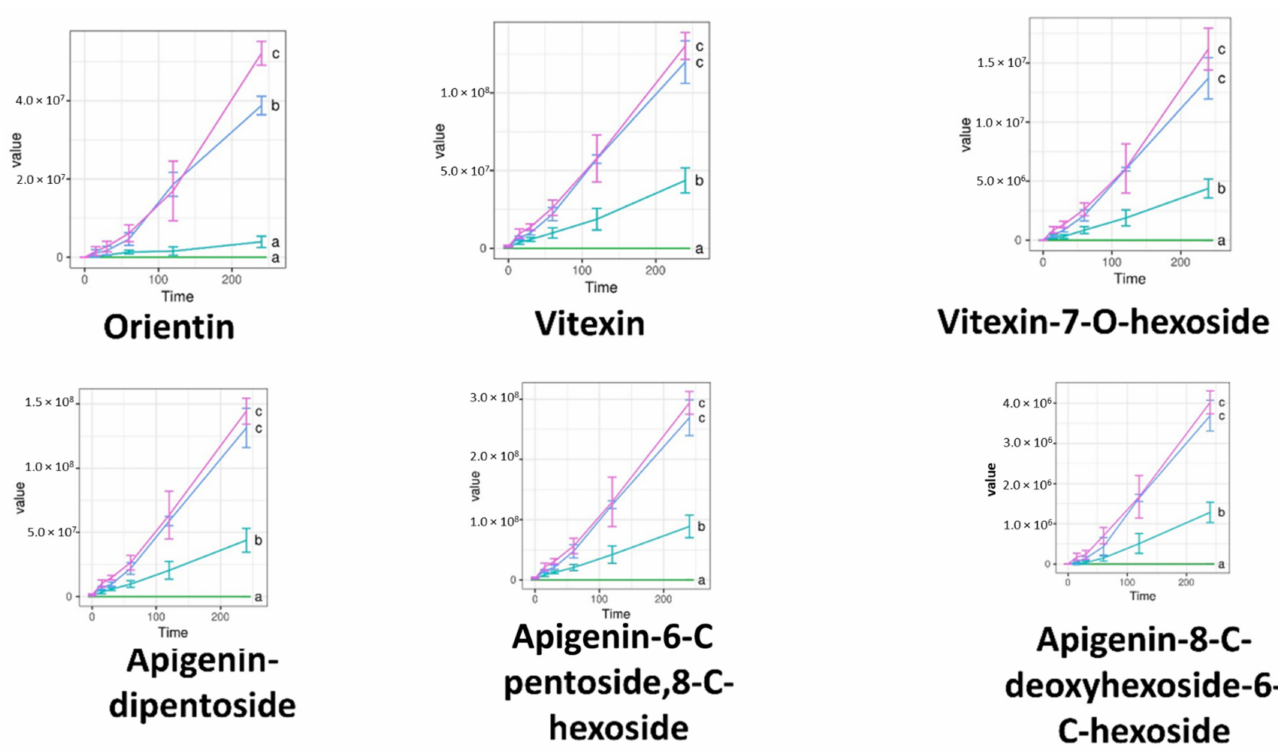
Figure 7. Abundance of Trigonella foenum-graecum compounds in the basal layer of Caco-2 cells, as measured by LC-ESI-MS. Flavonoid glycosides were measured in negative ion mode. Data are given in raw abundance. Abbreviations denote compositions of the upper layer, as in Table 3. The curves marked with different letters differ significantly according to Tukey’s HSD post-hoc